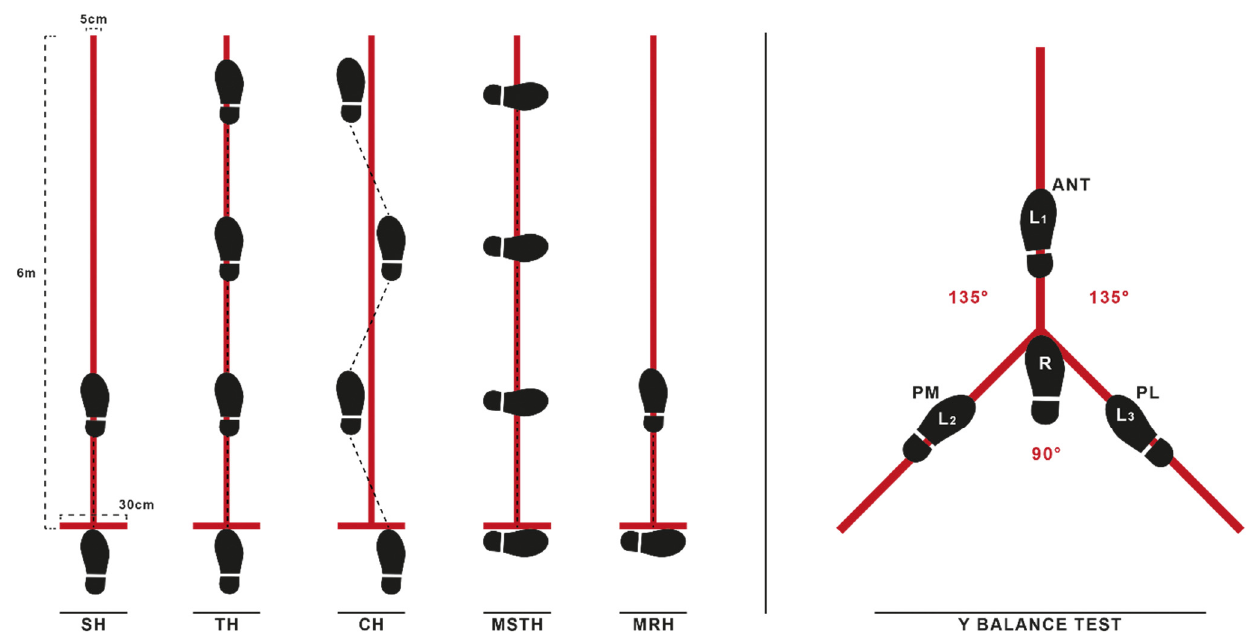
Figure 4. Demonstrations of SLHTs and Y balance tests. SH single leg hop for distance; TH triple hop for distance; CH crossover hop for distance; MSTH medial side triple hop for distance; MRH medial rotation (90°) hop for distance; ANT anterior; PL posterolateral; PM posteromedial.